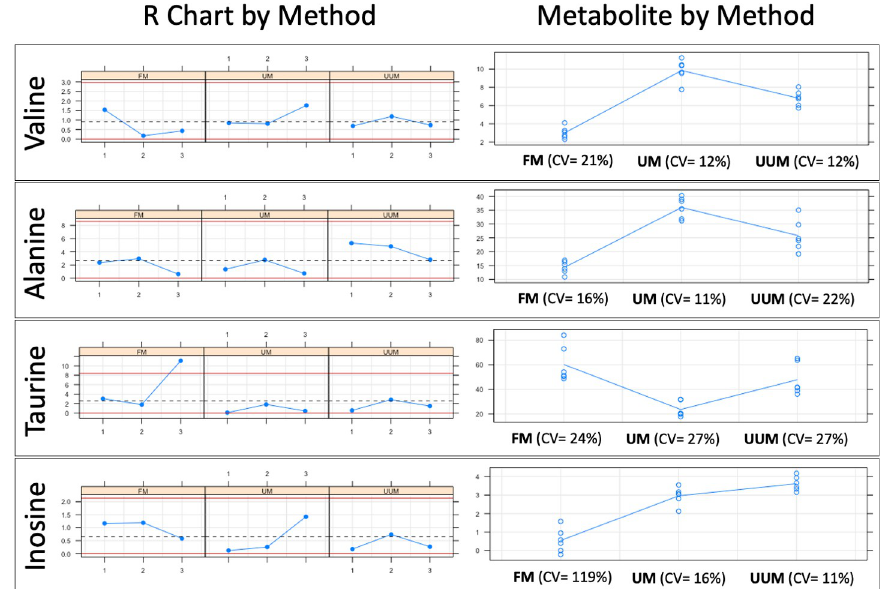
Fig 4. Six Sigma Gage R&R Measure. A comparative repeatability and reproducibility analysis (FM vs. UM vs. UUM) for metabolites Valine, Alanine, Taurine and Inosine was carried out using the Six Sigma tool from RStudio. FM: Folch Method, UM: Ultrasound Method, UUM: Ultrasound and Ultrafiltration Method, R Chart by Method: Range chart by method (Numbers 1, 2, and 3 on the x-axis: Patients evaluated; Differences in normalized concentration values on the y-axis), Metabolite by Method: Metabolite concentration of samples by method (Methods evaluated on the x-axis; Normalized concentration values on the y-axis), CV: coefficient of variation as a percent. https://doi.org/10.1371/journal.pone.0247668.g004 which may affect the power of the statistical tests performed. For example, the normality test (Shapiro-Wilk test) was used as a means to select whether to take a parametric or non- parametric approach to testing the hypothesis and contrast the methods and its metabolites. In